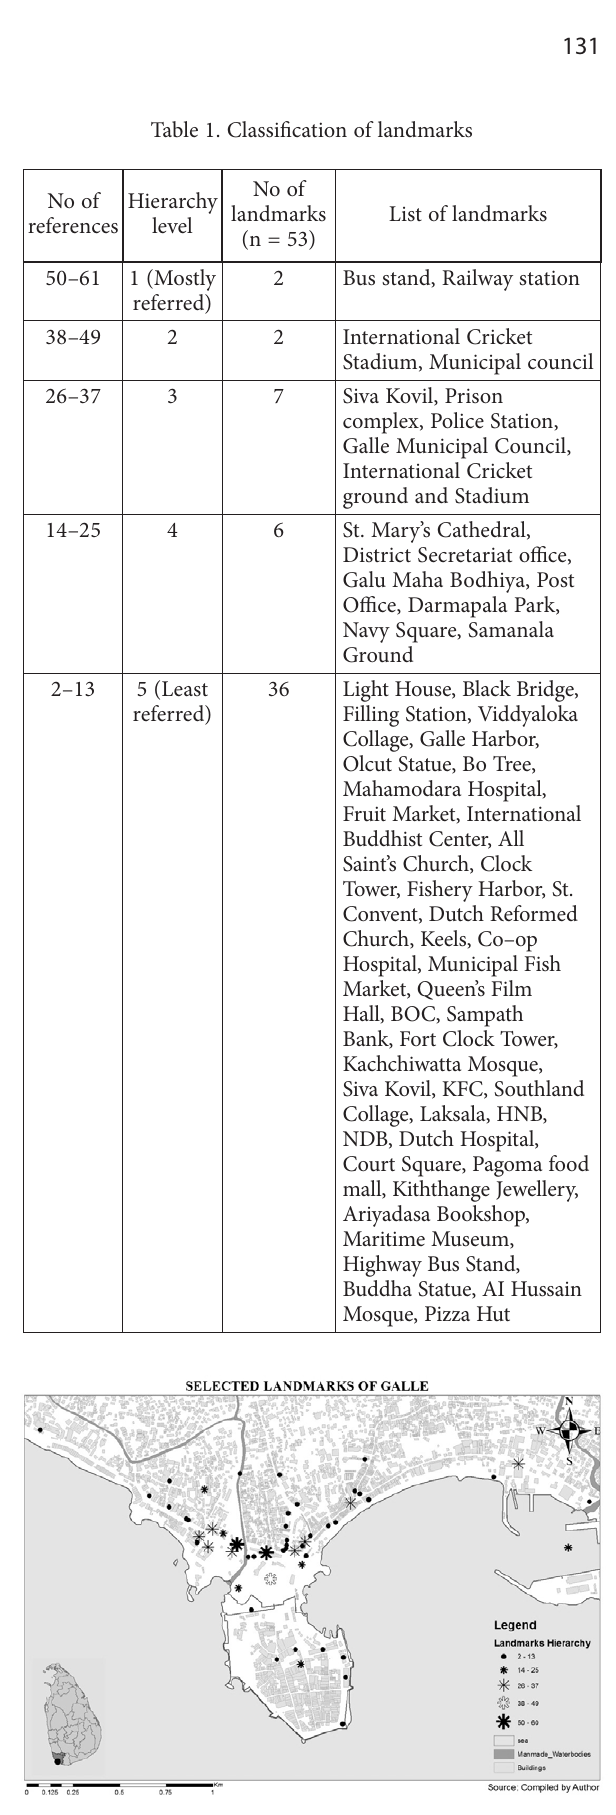
Figure 4. Landmark saliency level in Galle heritage